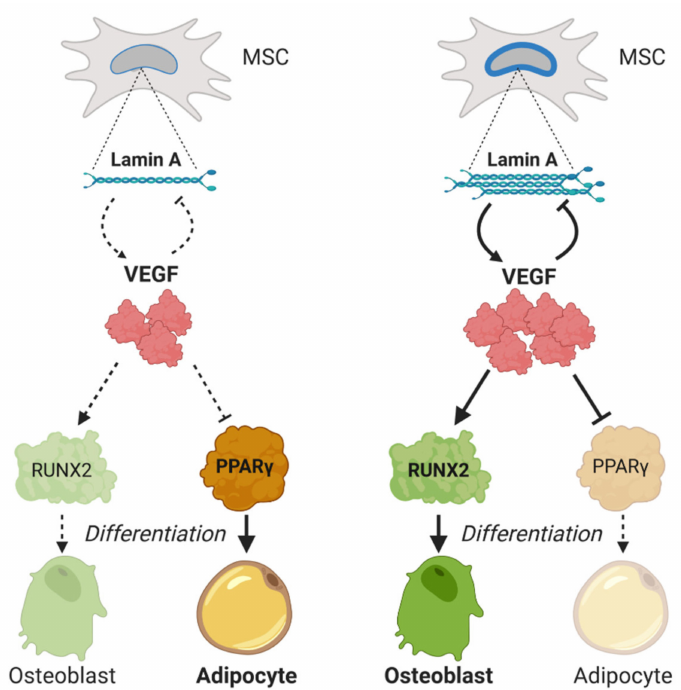
Figure 2. Mesenchymal stem cells’ (MSCs) fate is regulated by lamin A and vascular endothelial growth factor (VEGF) interaction. High levels of lamin A induce the expression of VEGF, which in turn induces the Runt-related transcription factor (RUNX2) transcription factor synthesis, responsible for osteoblast di ff erentiation, inhibiting the adipocyte di ff erentiation. However, low levels of VEGF lead to activation of the peroxisome proliferator-activated receptor (PPAR)- γ transcription factor, responsible of adipogenesis. Dashed lines represent the routes that are downregulated or